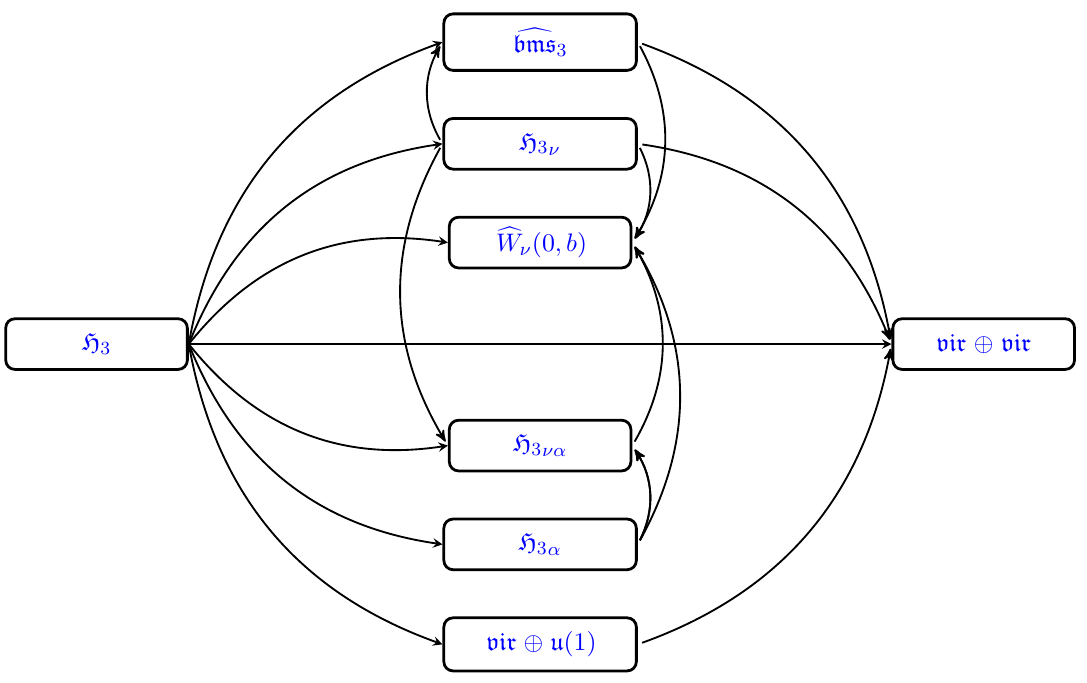
Figure 1 . Various algebras obtained as formal deformations of H 3 and their connections. Each line indicates a deformation/contraction relationship. The arrows signal the direction of deformation, while the contractions follow the inverse